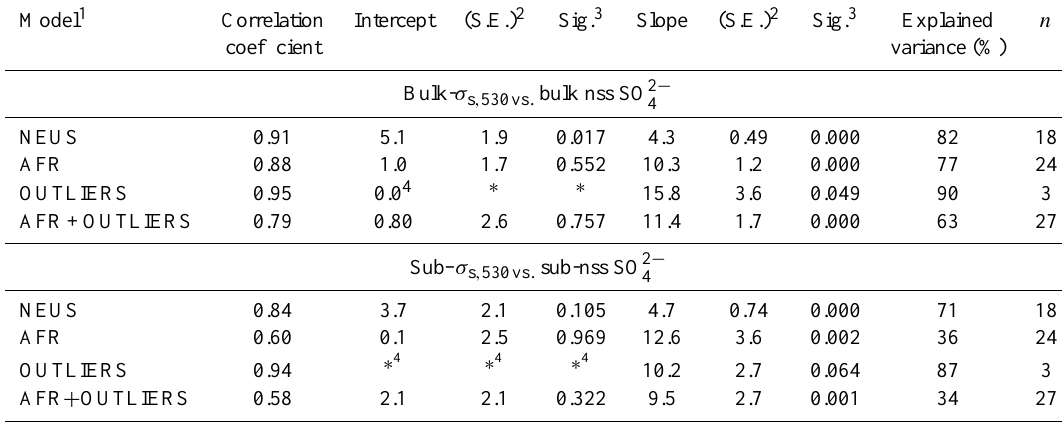
(µgm − 3 ), slopes are in units of m 2 gm − 1 . 4